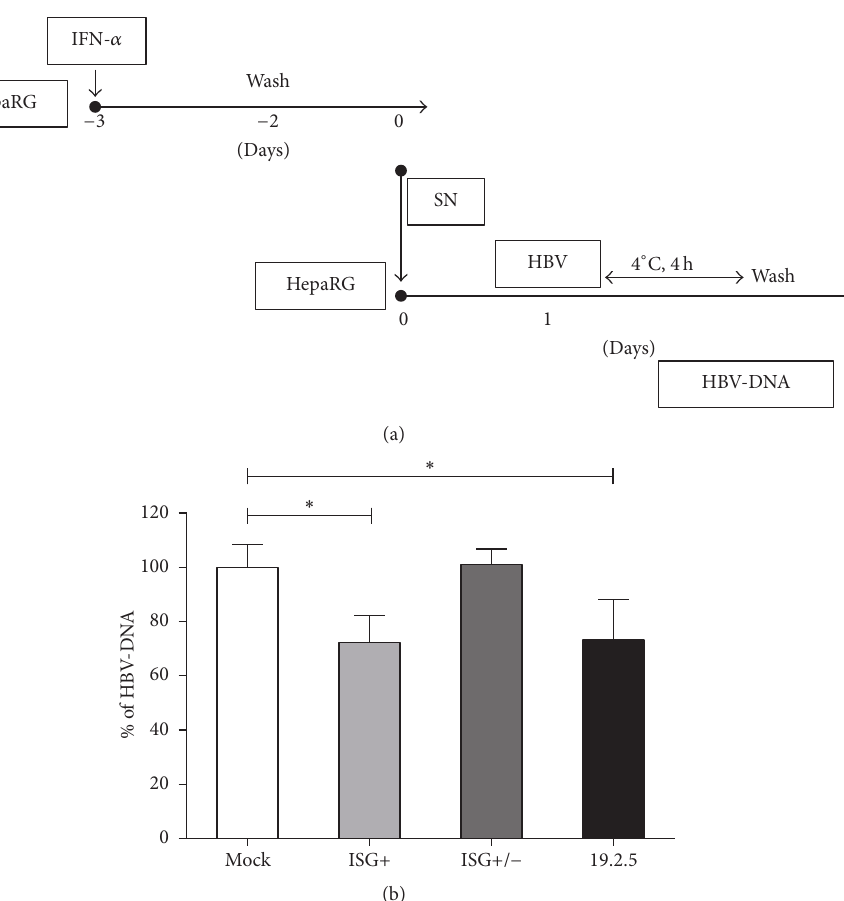
Figure 3: Secreted ISGs interrupt HBV binding. (a) Differentiated HepaRG cells were treated with 1000 IU/mL of IFN- 𝛼 . One day later, the medium was removed. Cells were washed three times with PBS and refilled with new medium. The resulting medium containing interferon induced factors (ISG+) was collected 48 hours later. Part of the medium was heated at 99 ∘ C for 10 minutes to inactivate proteins (ISG+/ − ). The medium was incubated with fresh differentiated HepaRG cells for 24 hours followed by 4 hours of HBV incubation at 4 ∘ C. Peptide 19-2.5 was used as a positive control. (b) Cells were lysed and HBV-DNA were evaluated by qPCR. Data are means ± s.d. ∗ 𝑃 < 0.05 , ∗∗ 𝑃 < 0.01 , and ∗∗∗ 𝑃 < 0.001 by Student’s unpaired two-tailed 𝑡 -test.